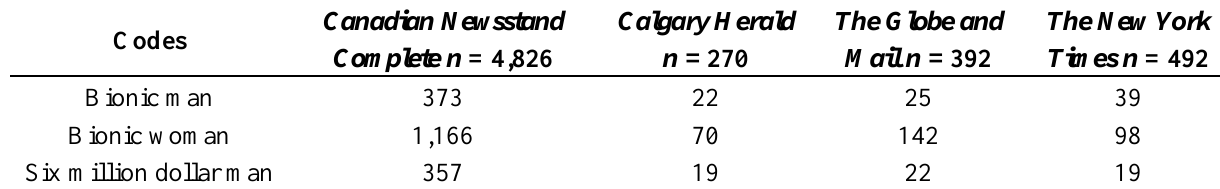
Table 6. Frequency of use of terms related to